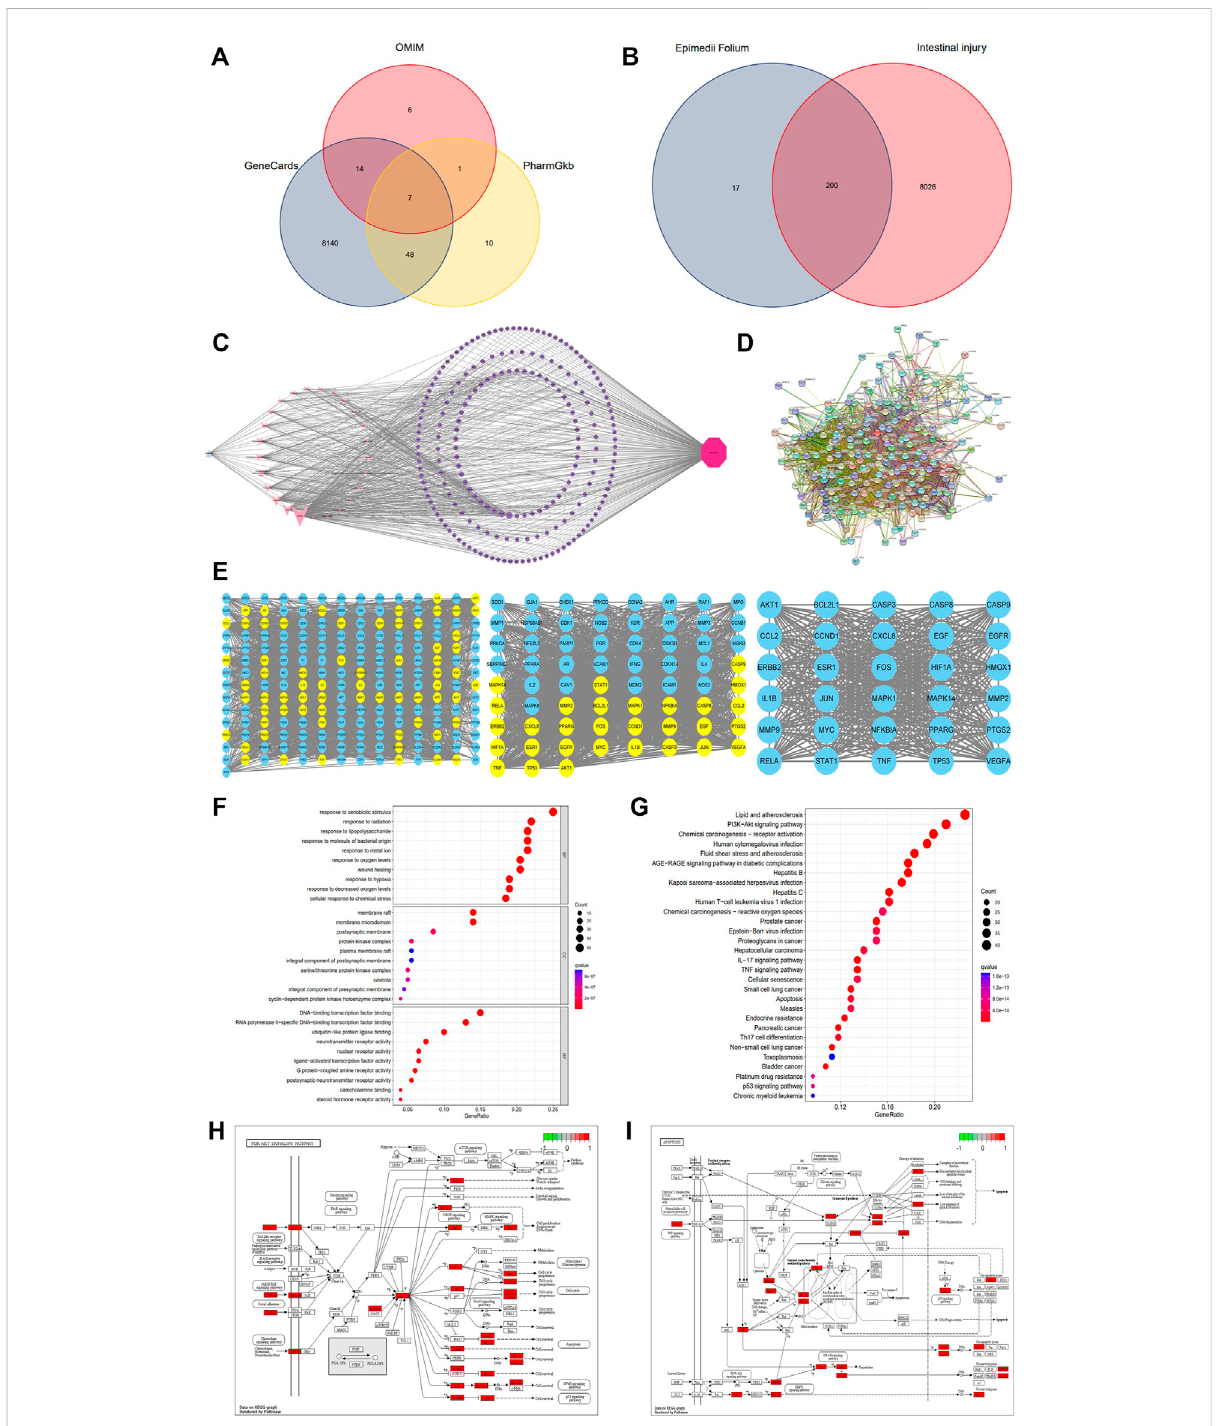
FIGURE 1 Venn diagram of three databases of intestinal injury (A) ; Venny results of the potential target genes of Epimedii Folium in the treatment of intestinal injury (B) ; Compound-target-disease interaction network of Epimedii Folium and intestinal injury (C) ; The PPI network of disease-drug targets (D) ; Network diagram of the core targets of Epimedii Folium against intestinal injury (E) ; GO and KEGG enrichment analysis (F – G) ; The PI3K/ Akt and apoptosis signaling pathways of potential target genes of EFE in intestinal injury (H,I)